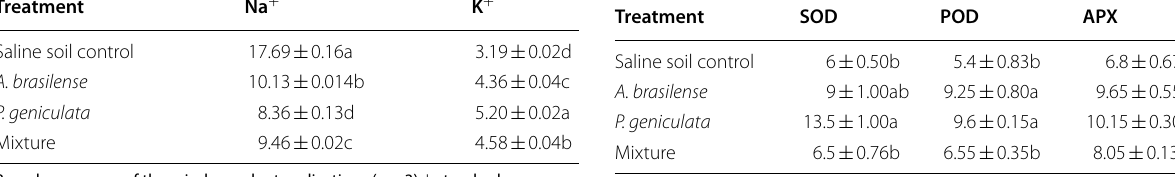
Bars show means of three independent replications (n Different letters indicate significant difference among means according to LSD test at p < 0.05